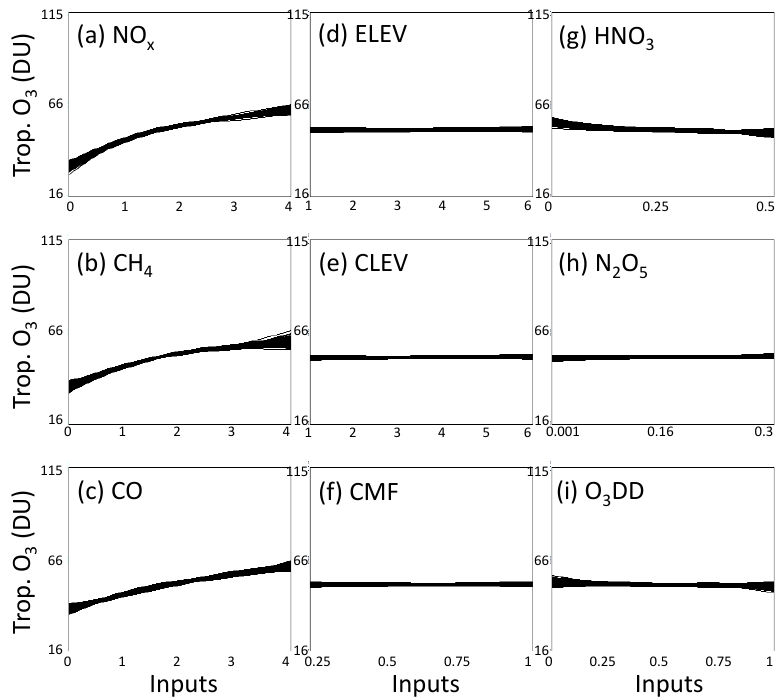
Figure 4. Sensitivity of annual global-mean tropospheric column ozone in 2005 to each of the nine sensitivity forcings/parametrizations listed in Table 1, averaging over the other inputs. The horizontal axis shows the range of scaling factors applied to each variable. Plots for individual regions (Europe, the United States, Asia and the Southern Ocean) are in the